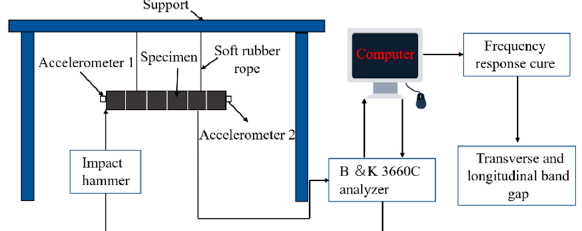
Figure 10. Band gap testing method.